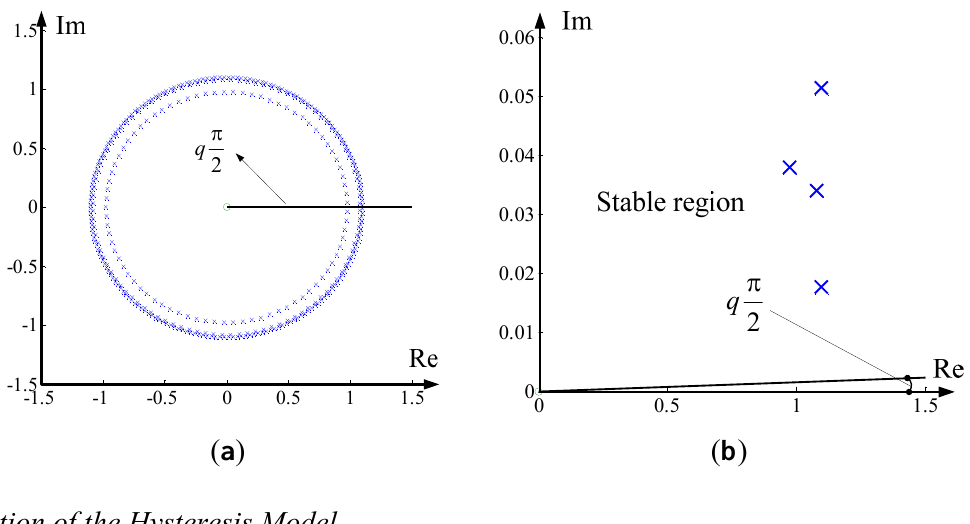
Figure 7. Pole positions with zoomed area: ( a ) pole positions; ( b ) zoomed